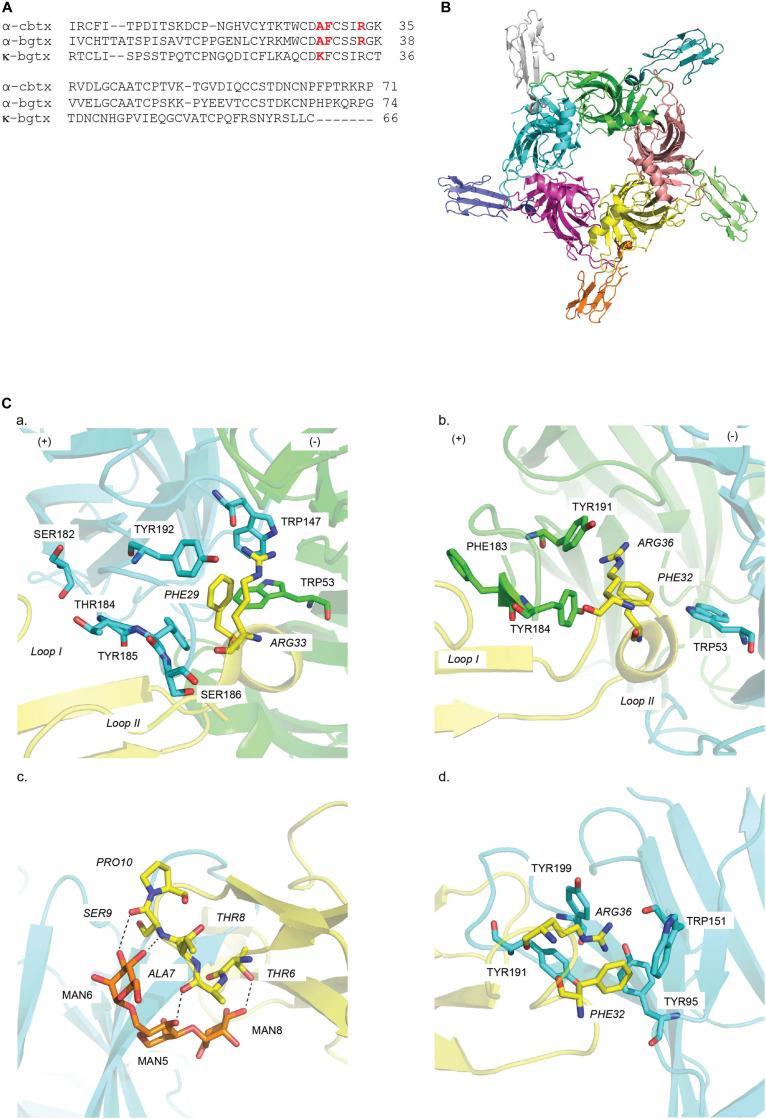
Structural mechanisms underlying snake toxin mediated nAChR inhibition: (A) Sequence alignment of snake toxins targeting nAChRs: α-cobratoxin (α-cbtx), α-Bungarotoxin (α-bgtx), and κ-Bungarotxin (κ-bgtx). Key residues in binding are highlighted in red. (B) α-cbtx occupied in all five binding pocket of Ls-AChBP as viewed along the AChBP fivefold axis (PDB 1YI5) (Bourne et al., 2005). (C) Key residues in the binding of (a) α-cbtx on the principal (+) (cyan) and the complementary (−) (green) face in Ls-AChBP (PDB 1YI5) (Unwin, 2005), (b) α-bgtx in the α7/Ls-AChBP chimera (Nemecz and Taylor, 2011) (PDB 3T4M), (c) mouse α1 nAChR subunit (PDB 2QC1) (Dellisanti et al., 2007) and (d) α9 nAChR ECD (PDB 4D01) (Zouridakis et al., 2014). Residues of snake toxins are italics. Hydrogen bonds are in dash line. MAN denotes for sugar moiety.